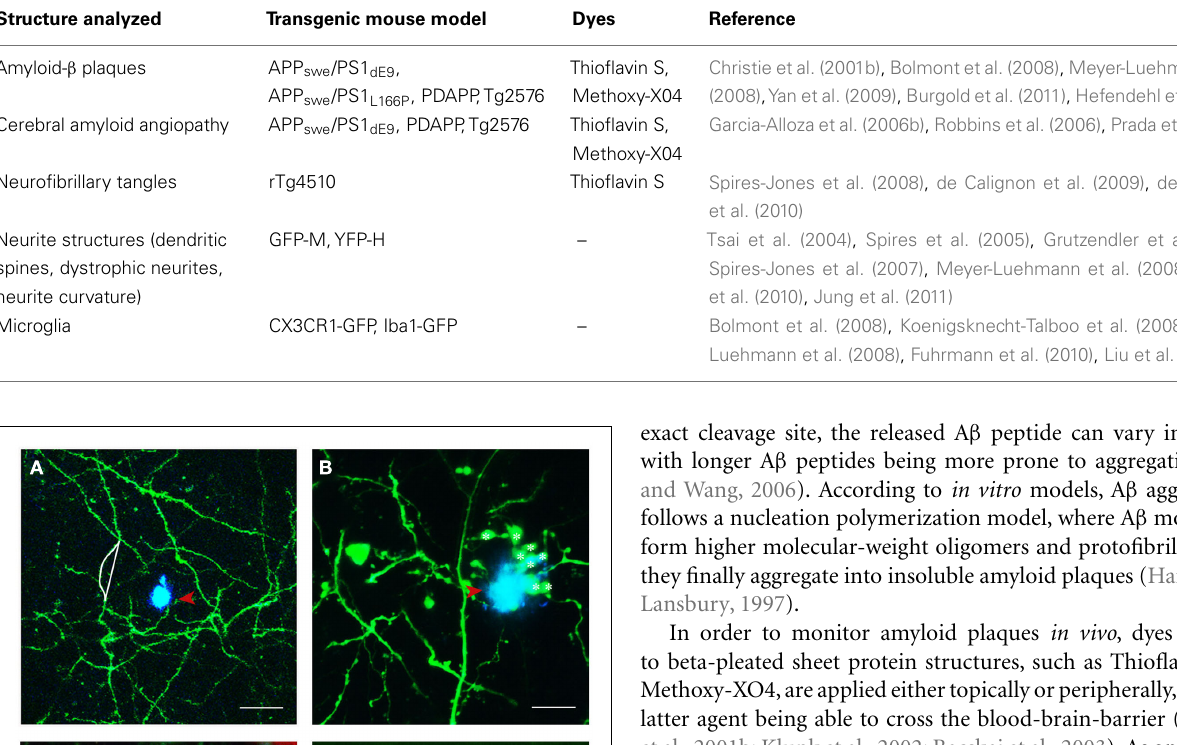
Table 1 | Structures analyzed in mouse models ofAlzheimer’s disease by in vivo two-photon